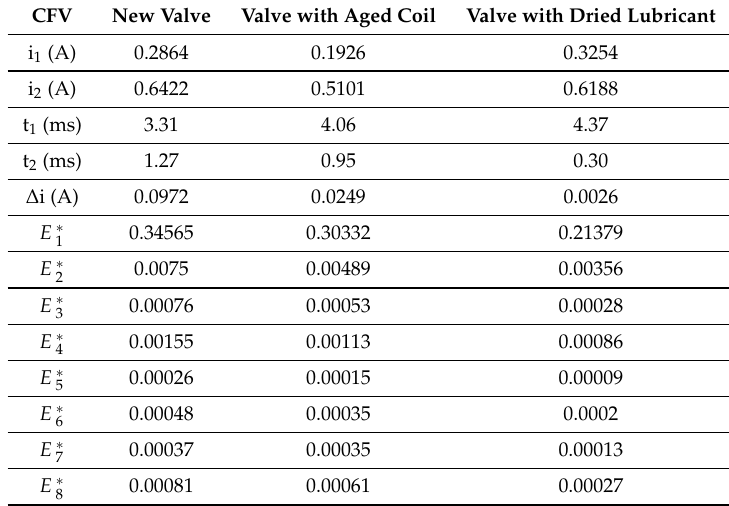
Table 3. Comprehensive feature vectors of solenoid valves under different states. CFV New Valve Valve with Aged Coil Valve with Dried